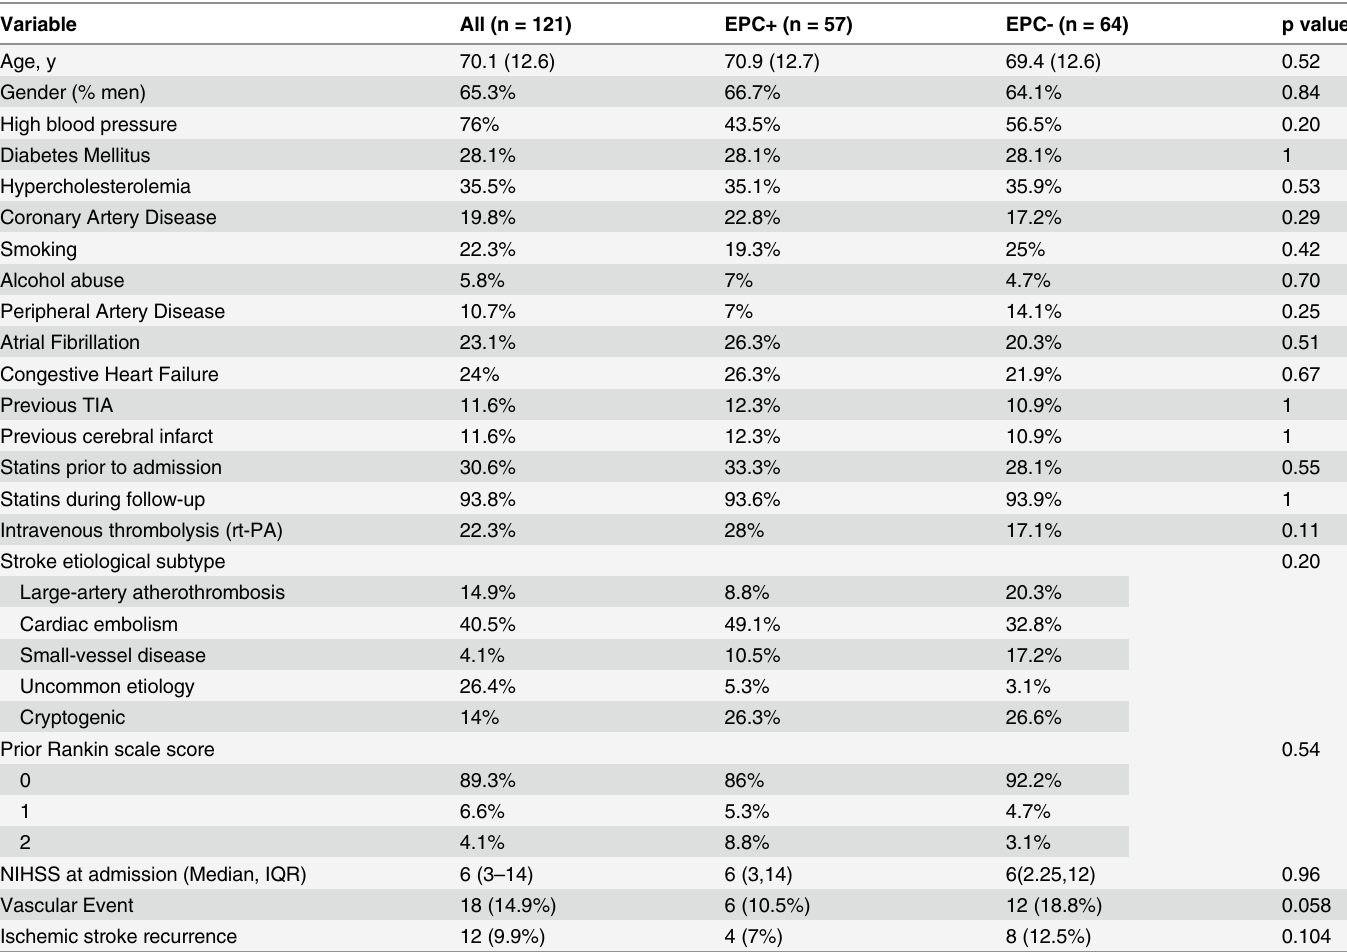
Table 1. Distribution of Variables in Patients with (EPC+) and Without (EPC-) Circulating